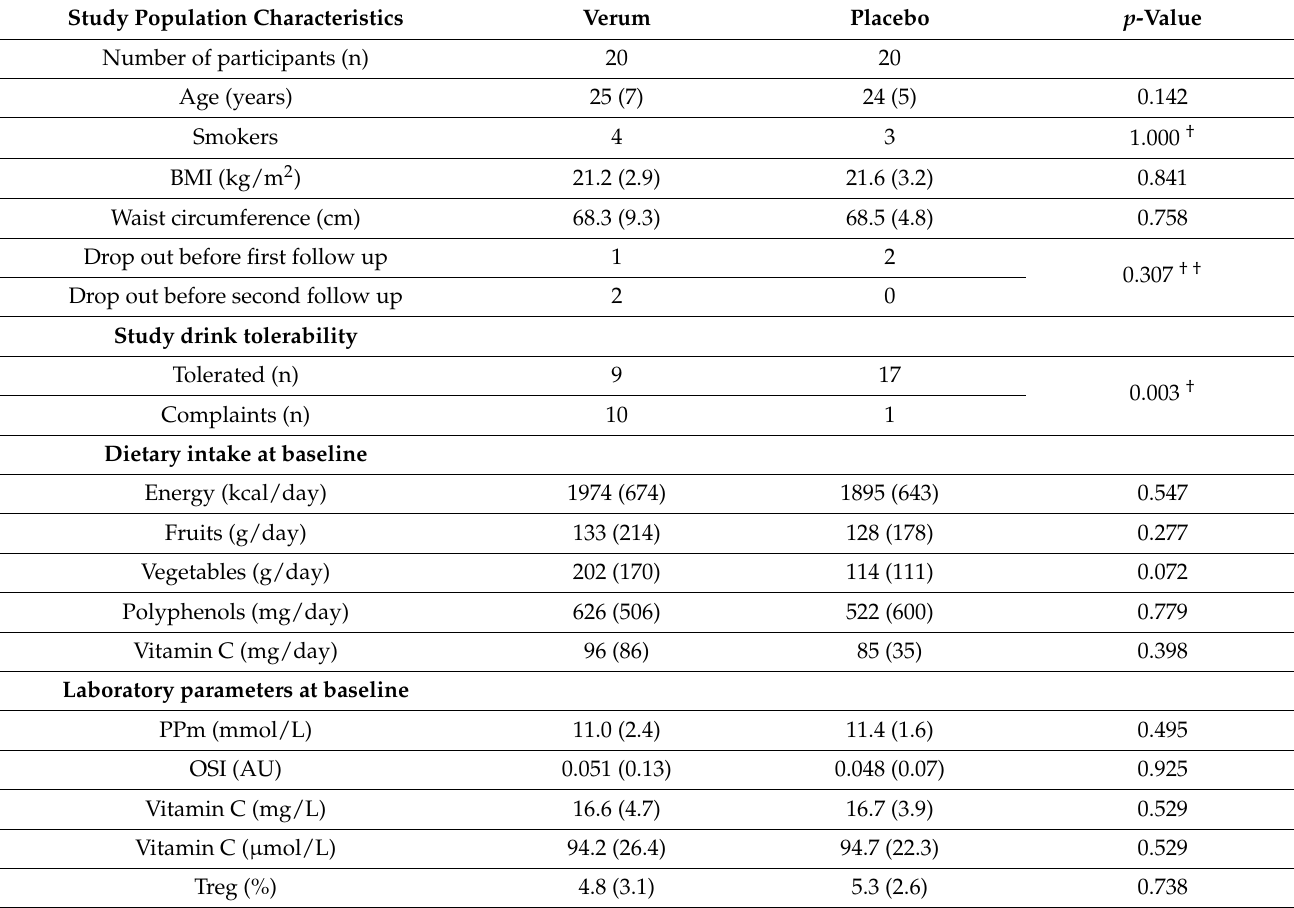
Table 1. Study population characteristics. Data are presented as median (IQR). p -values were derived from Mann–Whitney U test if not marked, from Fisher’s exact test if marked with † , and from chi-square test if marked with † †